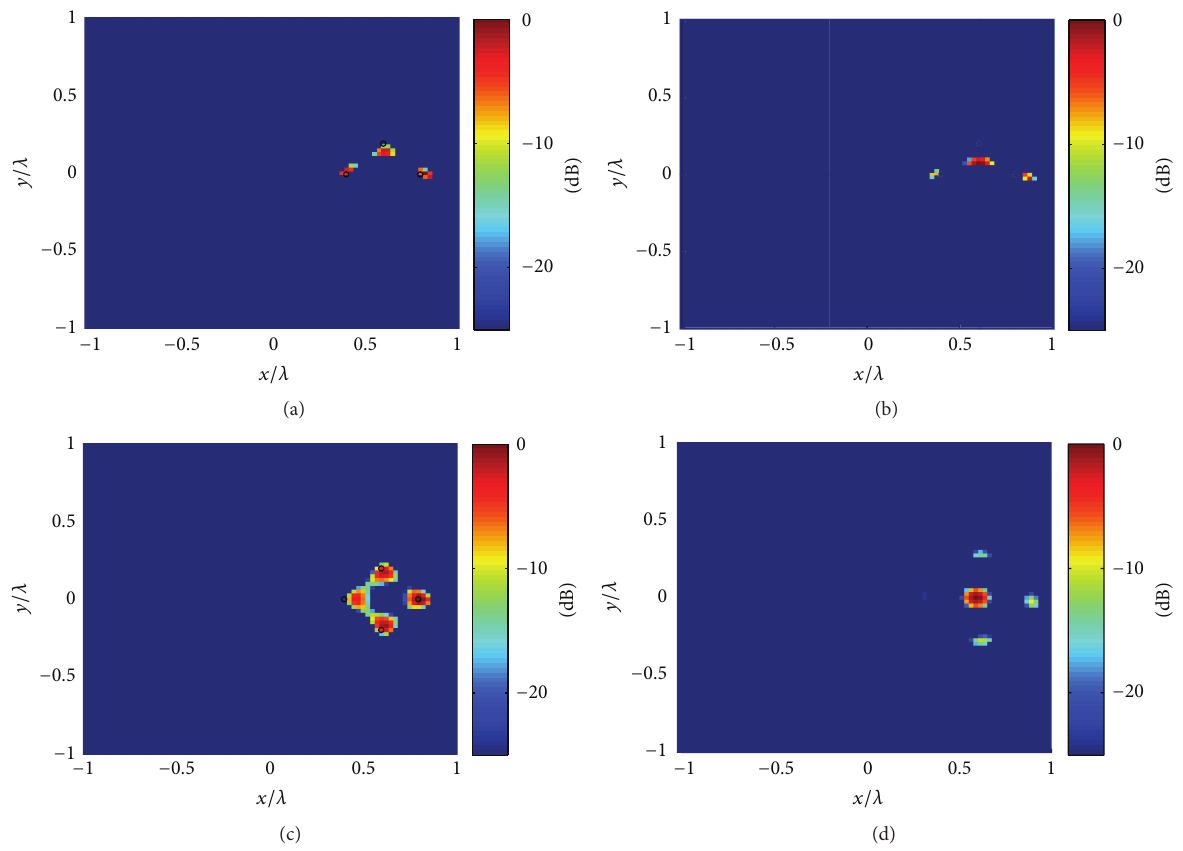
Figure 12: Normalised CS reconstructions for three scatterers ((a) and (b)) and four scatterers ((c) and (d)) with SNR = 20 dB for all panels. In (a) and (c) LD have been exploited whereas NLD have been used in (b) and (d). Actual scatterers’ positions are denoted by the black circle.